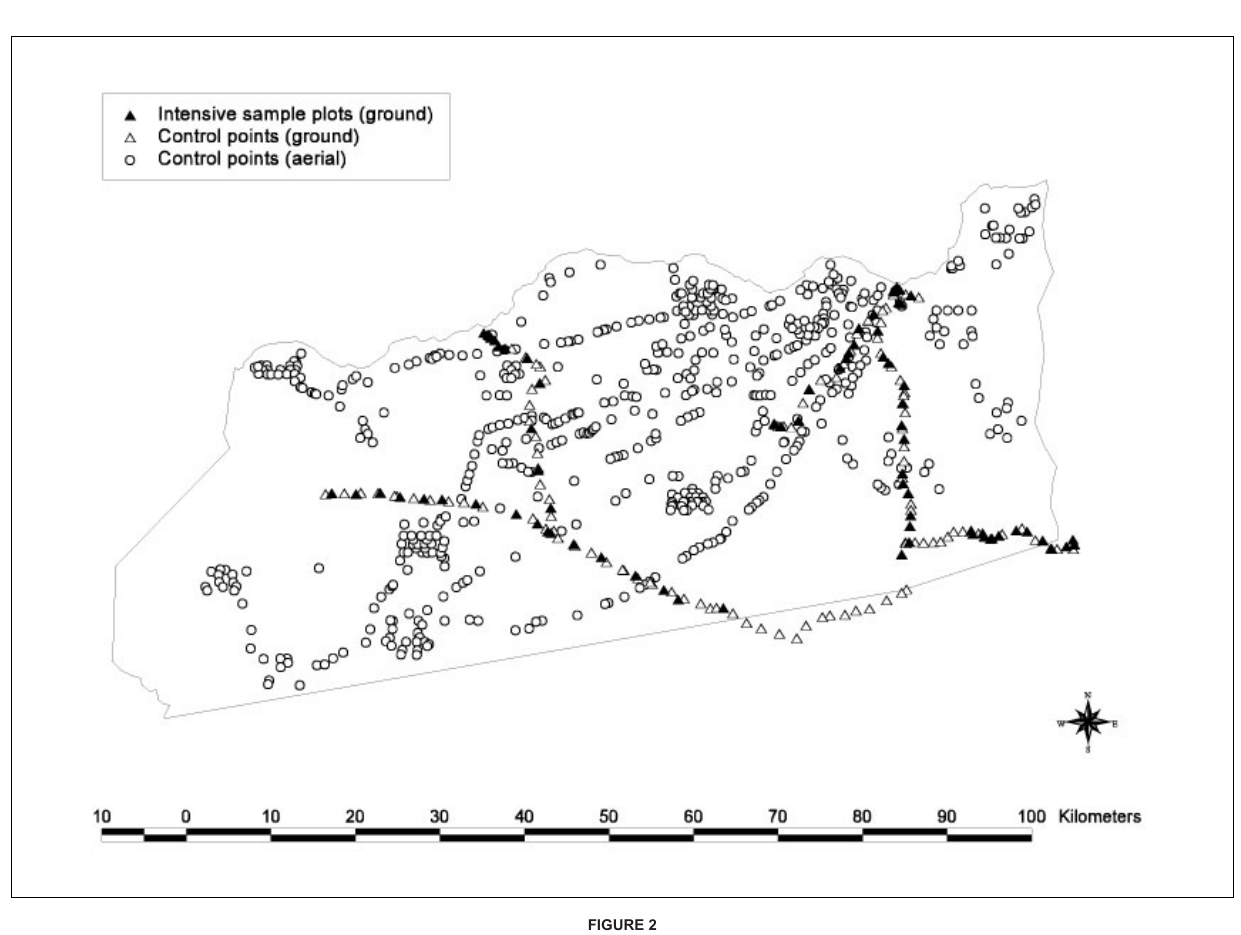
FIGURE 2 Position of vegetation sample plots as well as ground and aerial control points in the Parque Nacional de